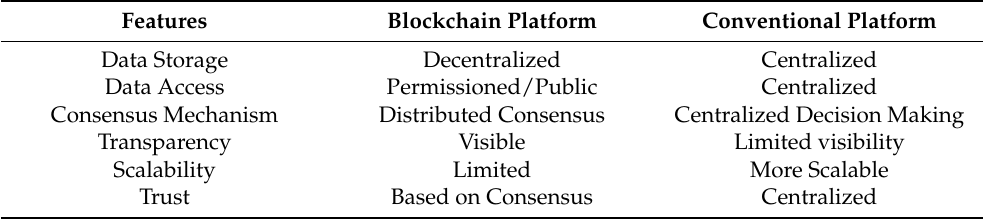
Table 2. Step-by-step procedure of use case scenario.